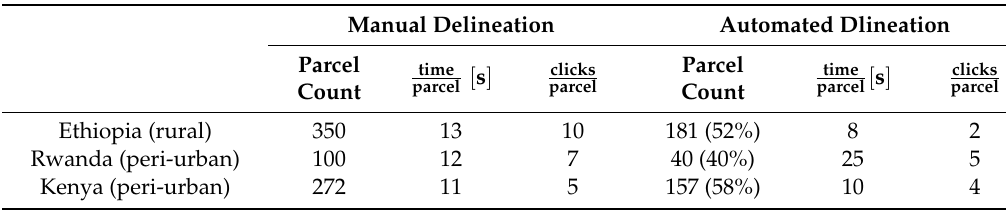
Table 6. Does automated delineation cost less e ff ort? Manual Delineation Automated